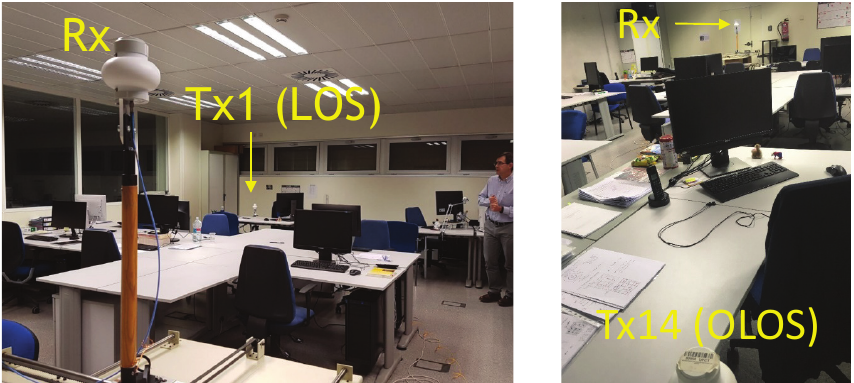
Figure 5. View of the Rx antenna and the Tx antenna in positions Tx1 in LOS (left) and Tx14 in OLOS